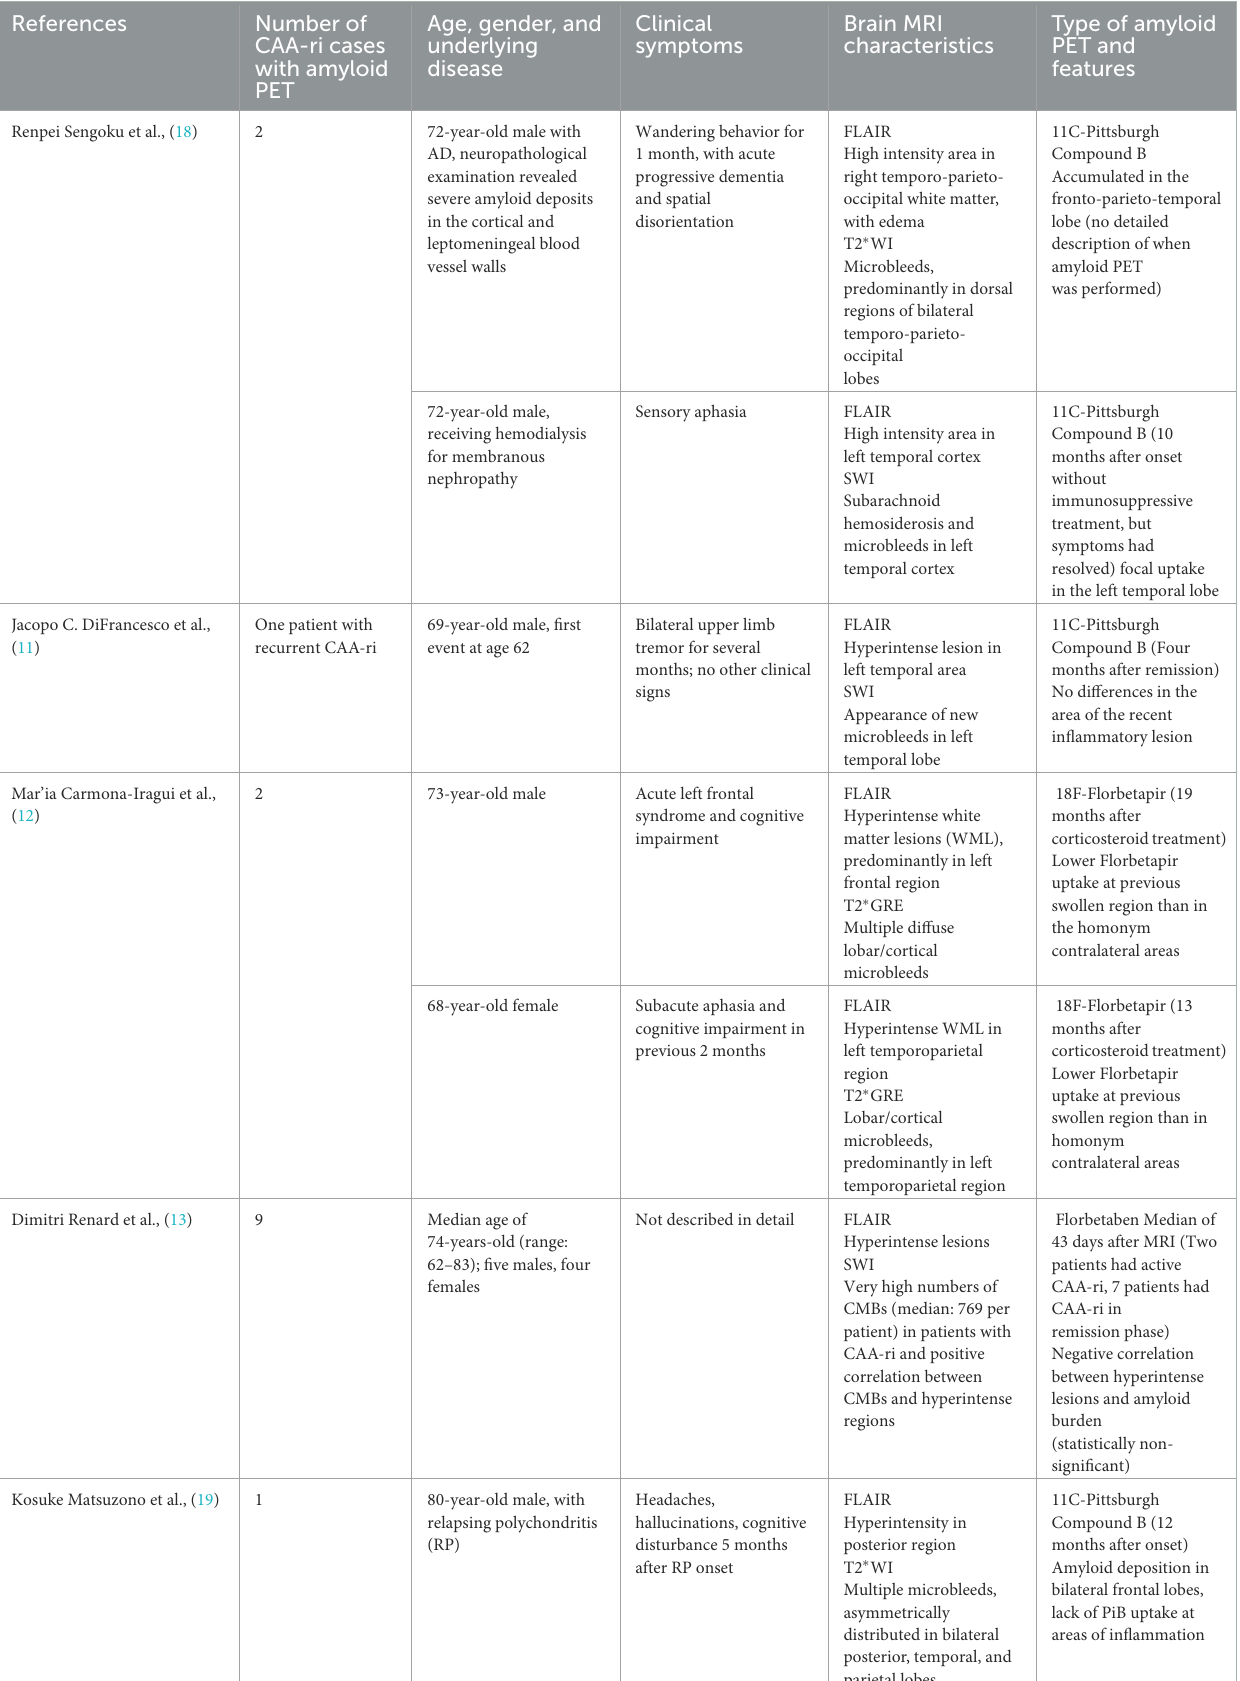
TABLE 1 Literature review of case reports and case series of CAA-ri with available amyloid PET